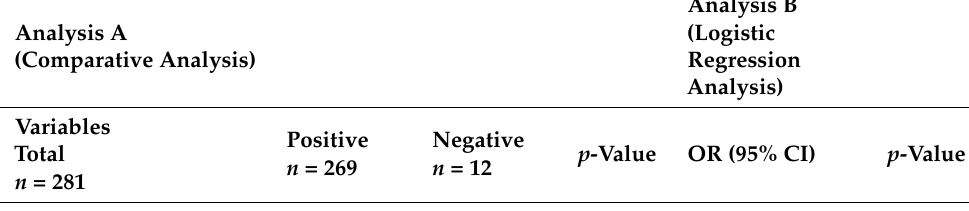
Figure 2. Monthly antibody status of the cohorts and timing of vaccinations. ( A ) Timing of vaccina- tions. ( B ) Cumulative antibody positivity in patients with available antibody status. Table 2. ( A ) Comparison of characteristics of patients who have received double dose vaccination by June 2021, based on the available antibody status in July 2021. ( B ) Binary logistic regression analysis (multi-variate model) to identify risk factors for attenuated antibody response following the second dose of